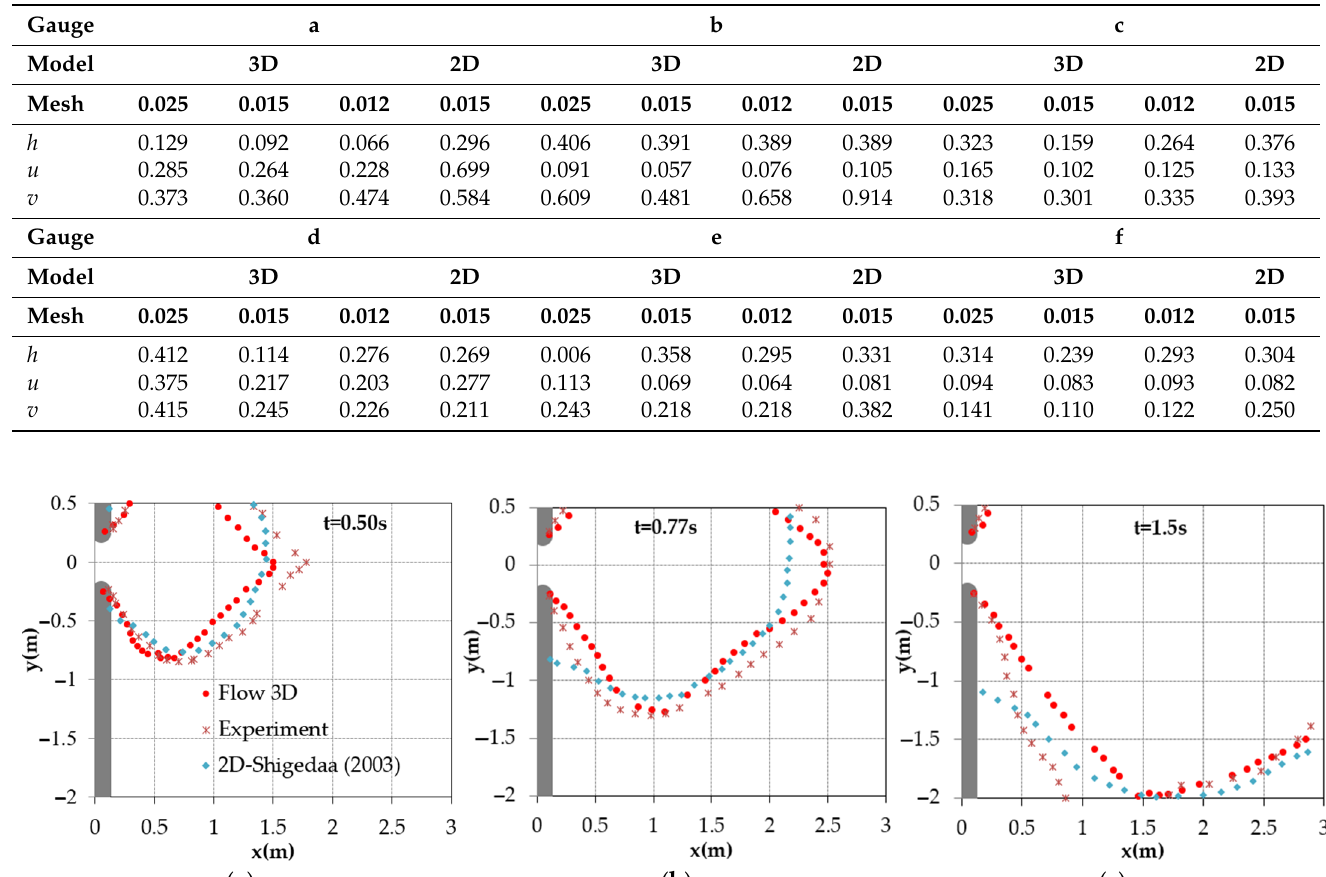
Table 2. RMSE value of water depth and velocity components.